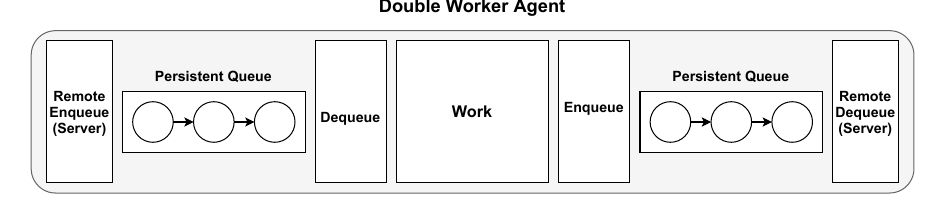
Figure 7. Double worker agent. A worker agent containing servers both before and after processing the